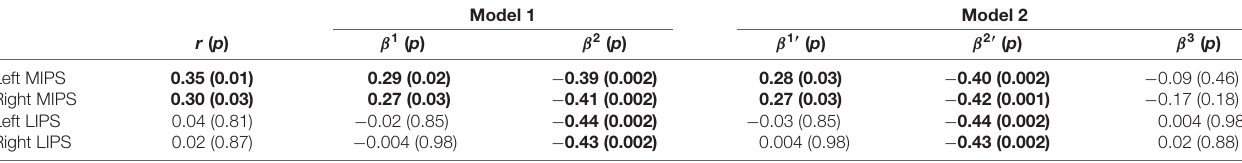
TABLE 6 | Relation between math performance on the WISC Arithmetic and regional IPS volumes, before and after adjustment for degree of prenatal alcohol exposure and potential moderation by prenatal alcohol exposure of the relations between regional IPS volumes and WISC Arithmetic. Model 1 Model